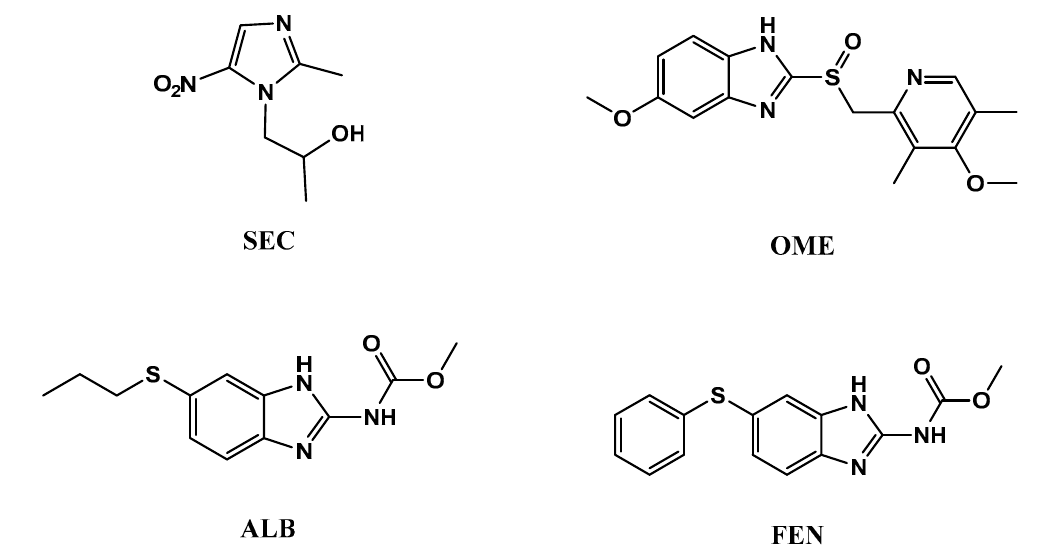
Figure 1. Chemical structures ofsecnidazole (SEC), omeprazole (OME), albendazole (ALB), and fenbendazole (FEN).